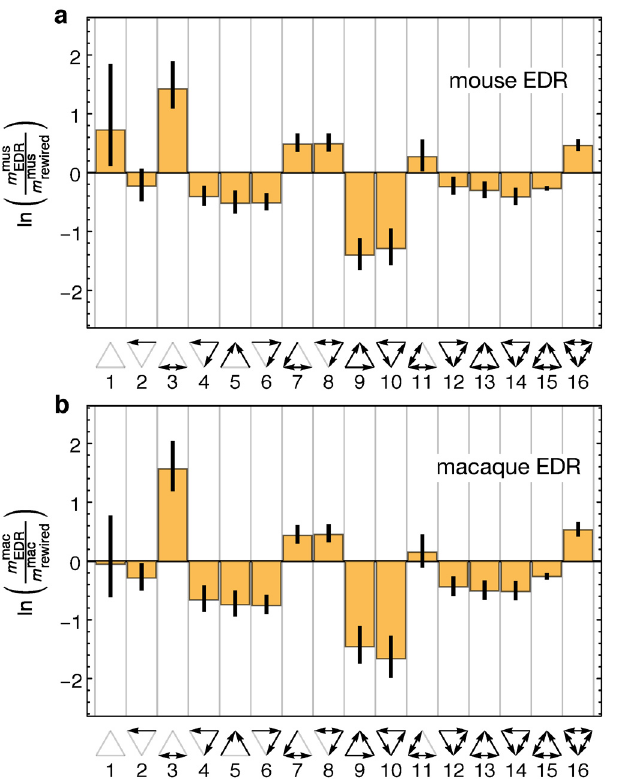
Fig 6. Macaque and mouse Motif distributions of EDR networks compared to a null model. The null model used for motif comparison is obtained from the network to which it is to be compared by a random rewiring of its connections in such a way as to preserve the in- and out-degrees. (a) Comparing motifs between the EDR model based on the macaque distance matrix and decay rate λ = 0.19 mm − 1 and the associated null model. (b) Same as in (a) but for the EDR model based on the mouse distance matrix, λ = 0.78 mm − 1 . This figure is analogous to Fig 5D but uses EDR model generated networks for comparison with null models instead of the empirical